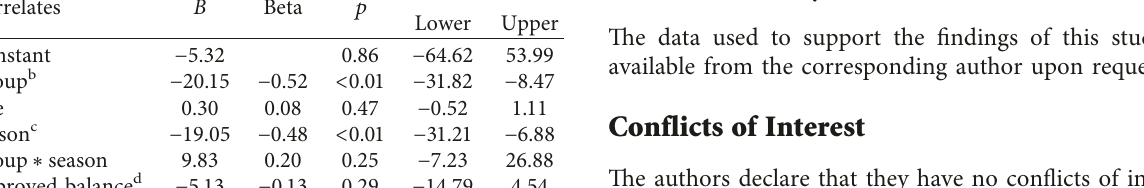
a Confidence interval. b Coded as 0 for intervention, 1 for control. c Spring/ summer � 0, fall/winter � 1. d ≥ 3 points of the Mini-BESTest total increase in brisk walking was not independently related to